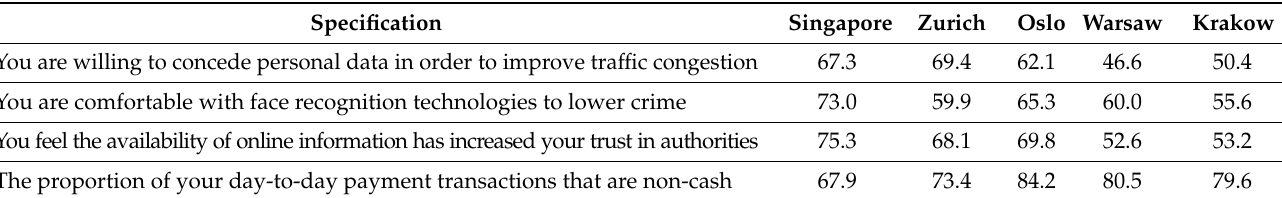
Table 4. A cumulative list of smart city scoring on the basis of the IMD-SUTD Smart City